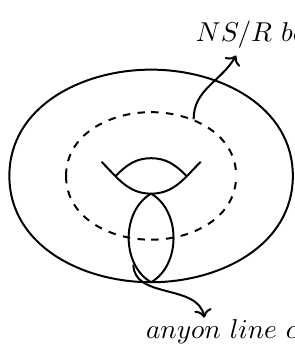
Figure 3 . A defect wrapping a cycle on the torus, while generating either periodic or anti-periodic boundary conditions for free fermions in the other cycle, determining the spin-structure on the